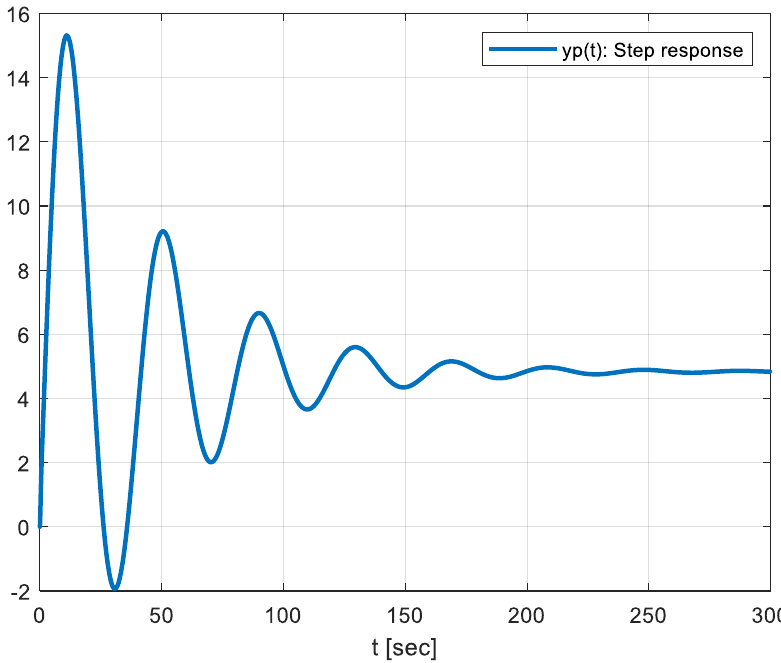
Figure 4. Plant open−loop response under a unit step input.